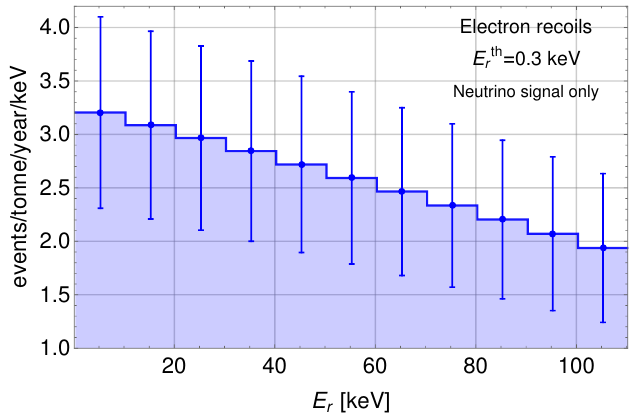
Figure 2 . Neutrino-electron signal for a 0 . 3 keV threshold with error bars amounting to 68% of the signal rate. The calculation assumes 100% detector efficiency and a one tonne-year exposure. Results are rather insensitive to threshold shifts (0.3 keV to 1